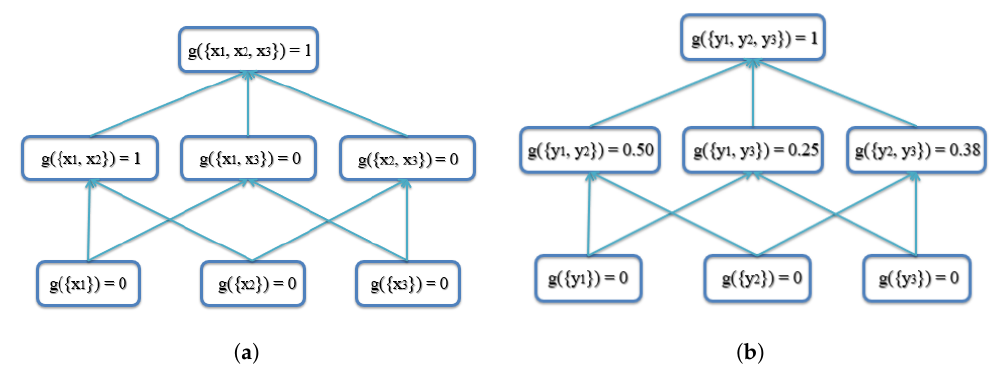
Figure 8. Lattice of the FM of agreement for the second example of three AABBs with one outlier. ( a ) Lattice of the FM of agreement on the x-axis for the second example; ( b ) lattice of the FM of agreement on the y-axis for the second